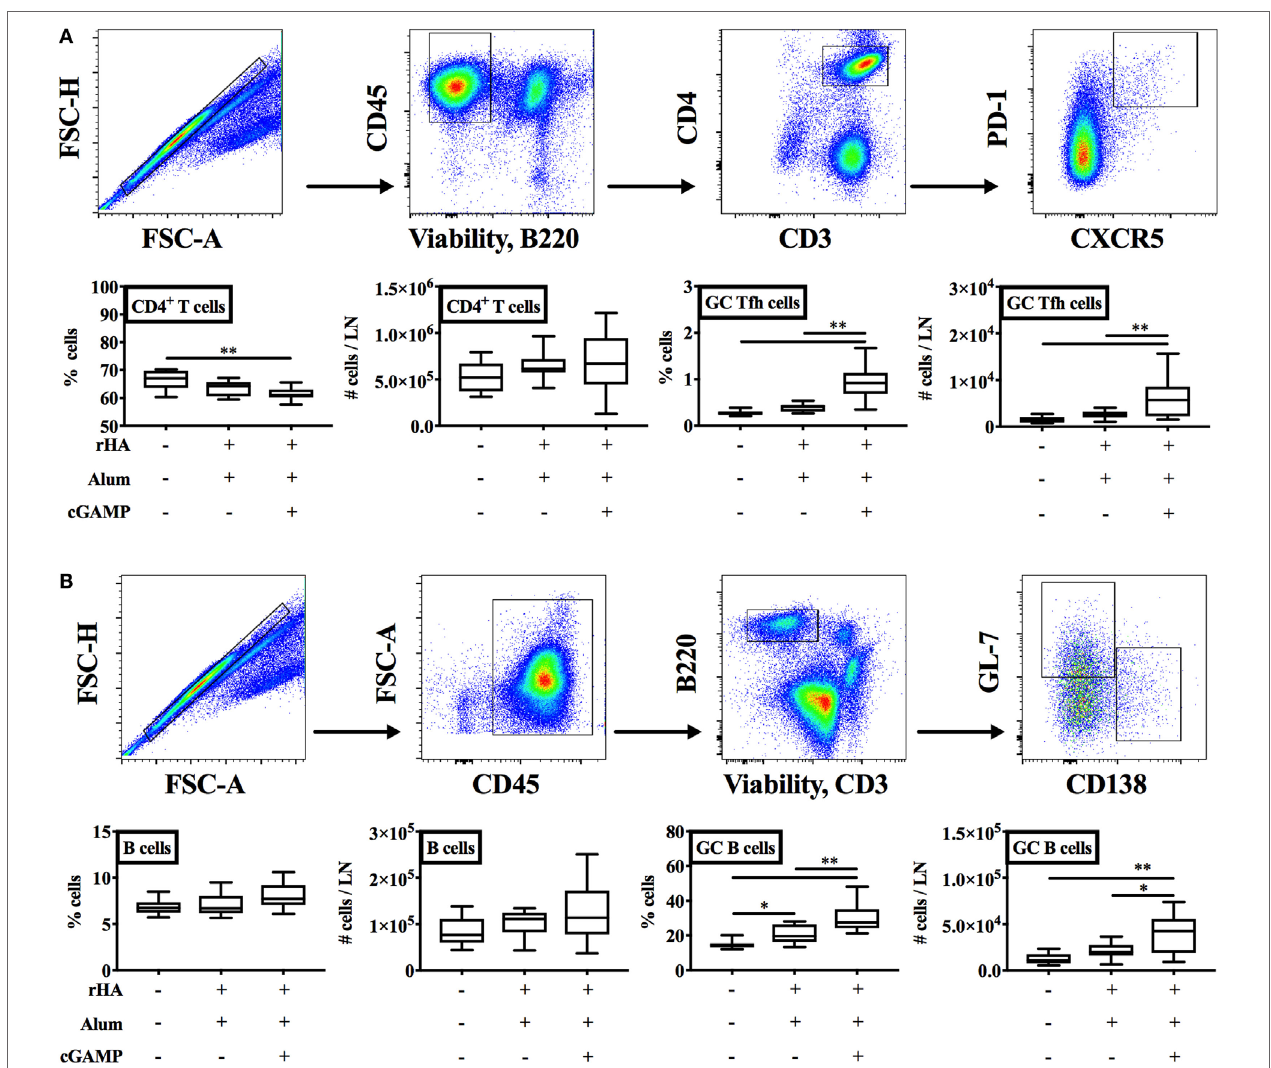
FigUre 5 | Immunization with (cGAMP + alum) fosters the germinal center (GC) reaction. Newborn mice were immunized with alum or (cGAMP + alum) as indicated in Figure 2a . Ten days after boost [day of life (DOL) 24] cells were isolated from draining lymph nodes and the percentages and absolute numbers of CD4 + T cells, B cells, GC Tfh, and B cells were assessed by flow cytometry. [ (a,B) top panels] Representative gating strategies. CD4 + T cells were defined as viable singlet CD45 + B220 − CD3 + CD4 + cells. GC Tfh cells were defined as viable singlet CD45 + B220 − CD3 + CD4 + CXCR5 + PD-1 + cells. B cells were defined as viable singlet CD45 + B220 + CD3 − cells. GC B cells were defined as viable singlet CD45 + B220 + CD3 − GL-7 + CD138 − cells. (B) Results are shown as the median, the 25th and 75th percentiles (boxes) and the 5th and 95th percentiles (whiskers) of 9–10 mice per group. * p < 0.05, ** p < 0.01 determined by one-way ANOVA with Holm–Sidak’s post hoc